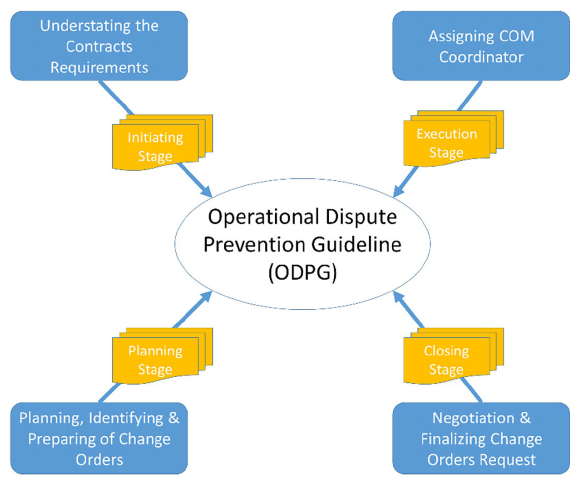
Figure 4. Operational Dispute Prevention Guideline